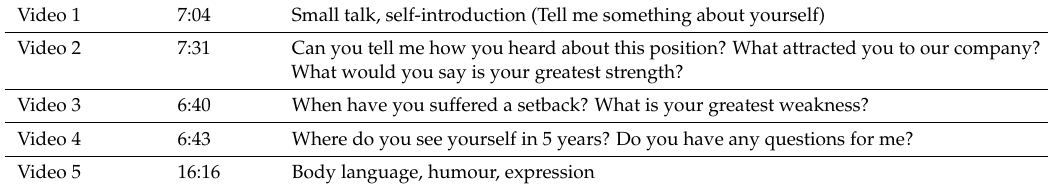
Table 1. The foci of each video in the How to Interview for a Job in American English series.